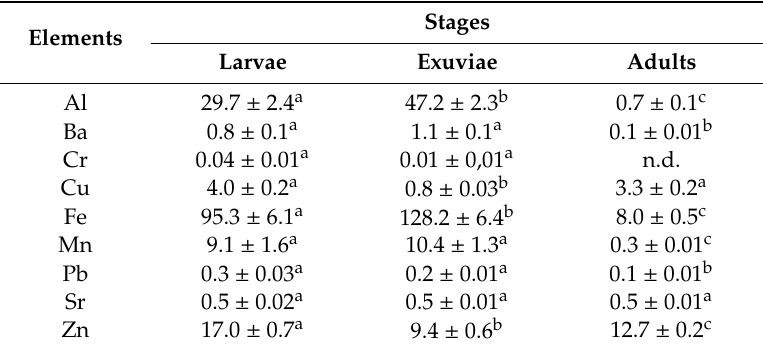
Table 2. Trace element contents per individual (expressed as mean ± standard error, unit: µ g) of G. flavipes developmental stages in the Tiszabercel studied area. Notation: n.d. = not detected, and di ff erent letters indicate the significant di ff erences at p <